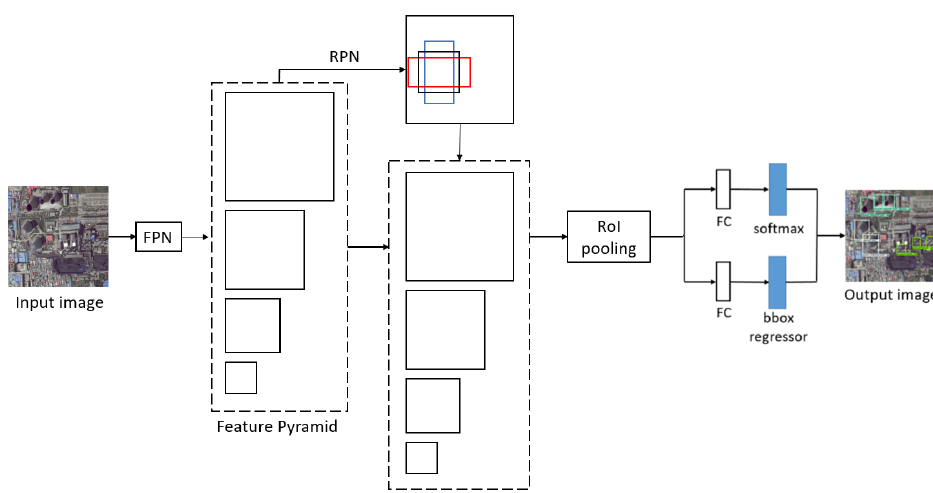
Figure 2. The framework of FPN. FPN, feature pyramid network; RPN, region proposal network; RoI, region of interest; FC, fully connected layer; bbox, bounding